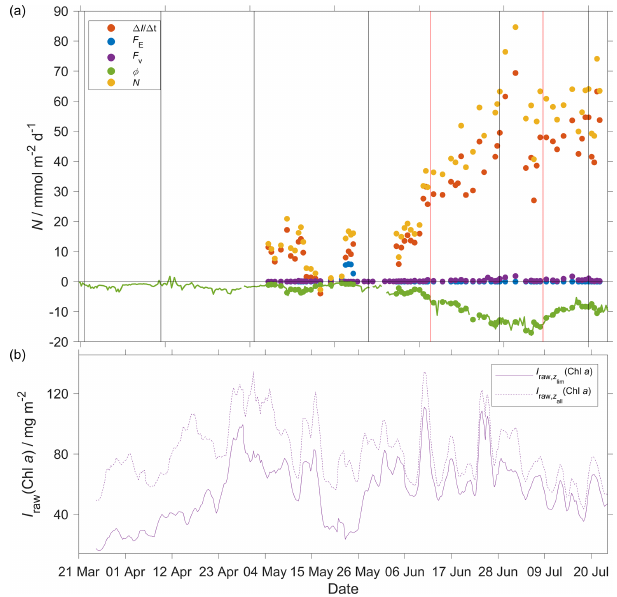
Figure 14. (a) Components of the N (DIC) calculation: (cid:49)I( DIC )/(cid:49)t (red), E (DIC) (blue), F v (CO 2 ) (violet), Φ (CO 2 ) (green) with k w (CO 2 ) weighted over 50d, N (DIC) (yellow). (b) Chl a inventory in the top 45m, I raw ,z inventory for the whole water column, I raw ,z violet line). The vertical black lines represent each glider transect. Between the two vertical red lines, the glider was in the NCC